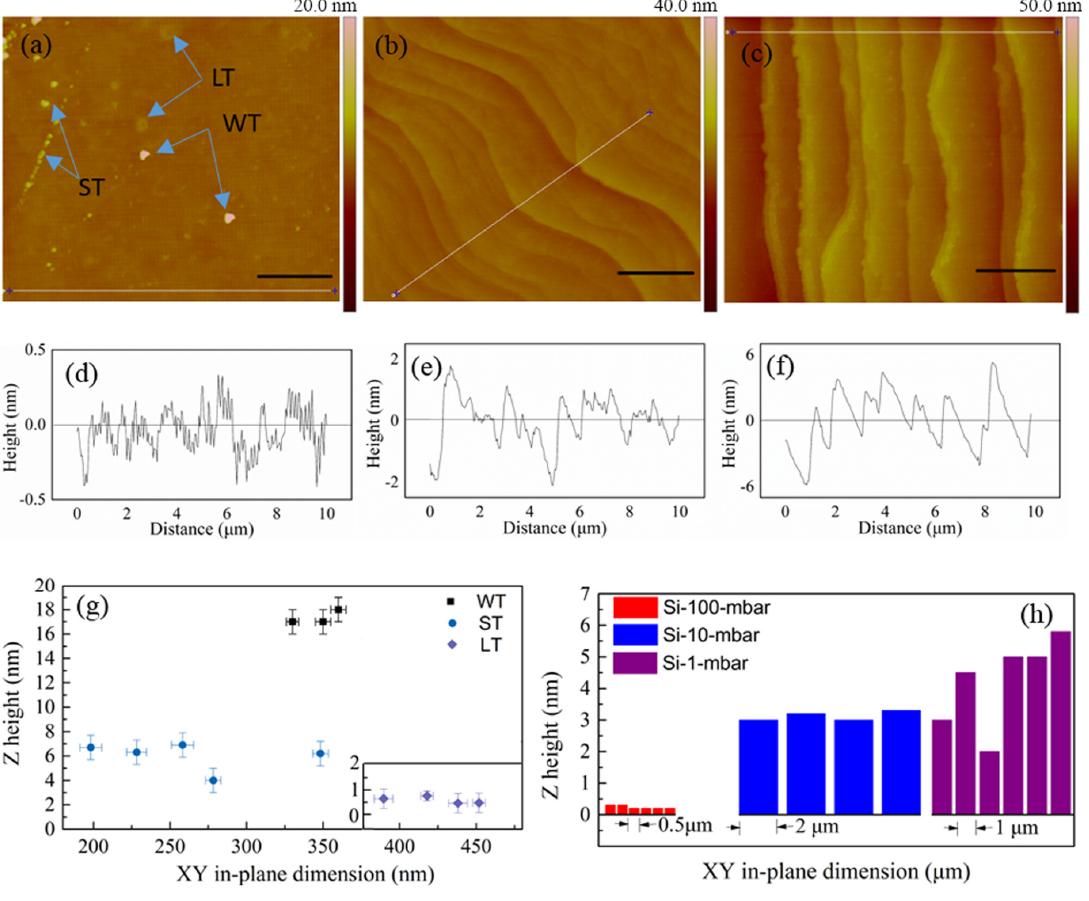
Figure 1. Epitaxial graphene (EG) samples grown on Si-faced 4H-SiC substrates. ( a ) Sample Si-100-mbar; ( b ) Sample Si-10-mbar; ( c ) Sample Si-1-mbar; ( d – f ) Atomic force microscopy (AFM) line profiles for the white lines in ( a ), ( b ) and ( c ), respectively; ( g ) Distribution of three dimensional sizes of individual terraces in ( a ); ( h ) Histograms of steps and terraces sizes of EG surfaces on Si-faced substrates. Scale bars: 2 μ m.